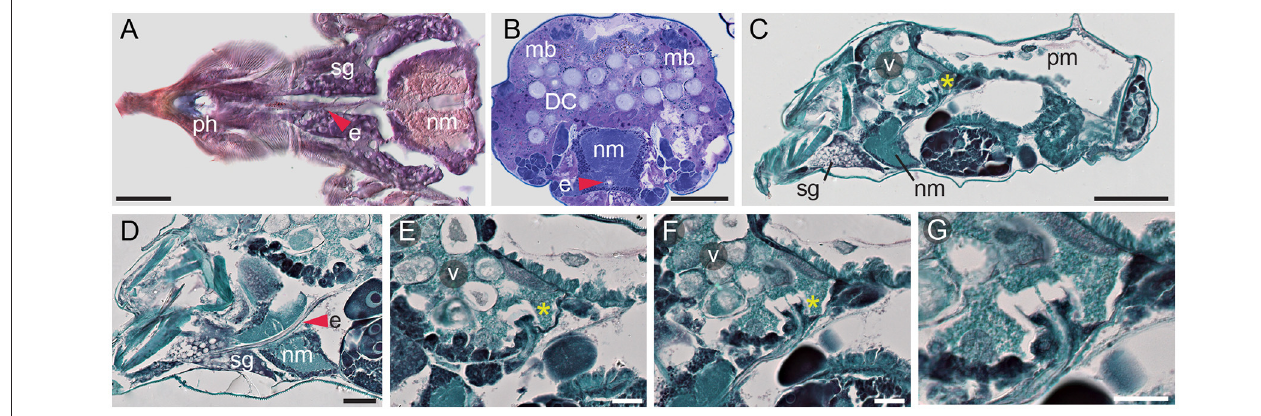
FIGURE 3 | Esophagus and esophageal valve of spider mite. (A) Longitudinal cryosection of ventral part of proterosoma showing pharynx (ph) connected to esophagus (e) that passes through the silk gland (sg) and the nervous mass (nm) stained with Oil Red O. (B) Transverse section showing esophagus passing through nervous mass. Dorsal muscle bundles (mb) that facilitate midgut movement are clearly visible. LR White plastic embedding and Toluidine Blue staining. DC, digestive cells. (C) Sagittal section of female spider mite. Esophageal valve (asterisk) entering ventriculus (v). pm, posterior midgut. (D) Sagittal section through proterosoma of spider mite showing esophagus (red arrowhead) passing through silk gland and nervous mass toward ventriculus. (E,F) Consecutive sections through the esophageal valve (asterisk) entering the ventriculus. (G) Detail of esophageal valve entering ventriculus. Paraffin embedding and Fast Green and Safranin O staining were used in (C–G) . Scale bars: (A) : 25 µ m; (B) : 50 µ m; (C) : 100 µ m; (D) : 25 µ m; (E–G) : 20 µ